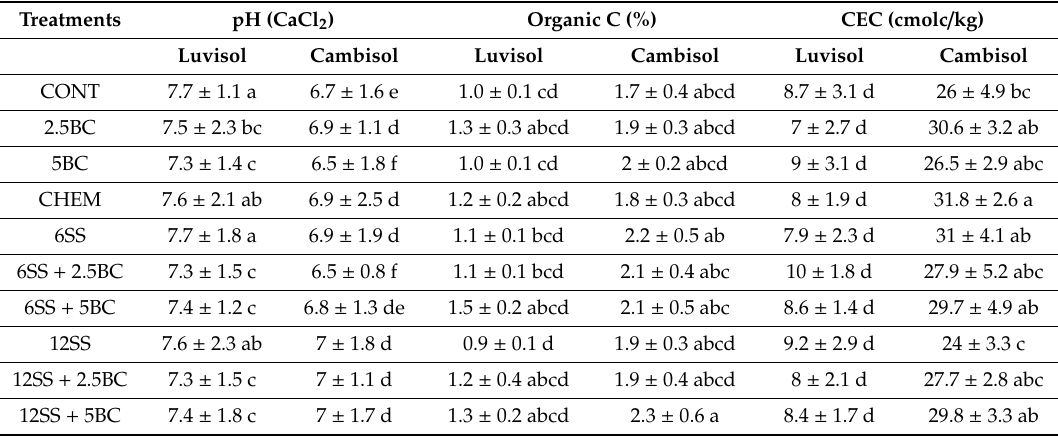
Table 4. E ff ects of di ff erent treatments on post-harvest soil chemical properties.